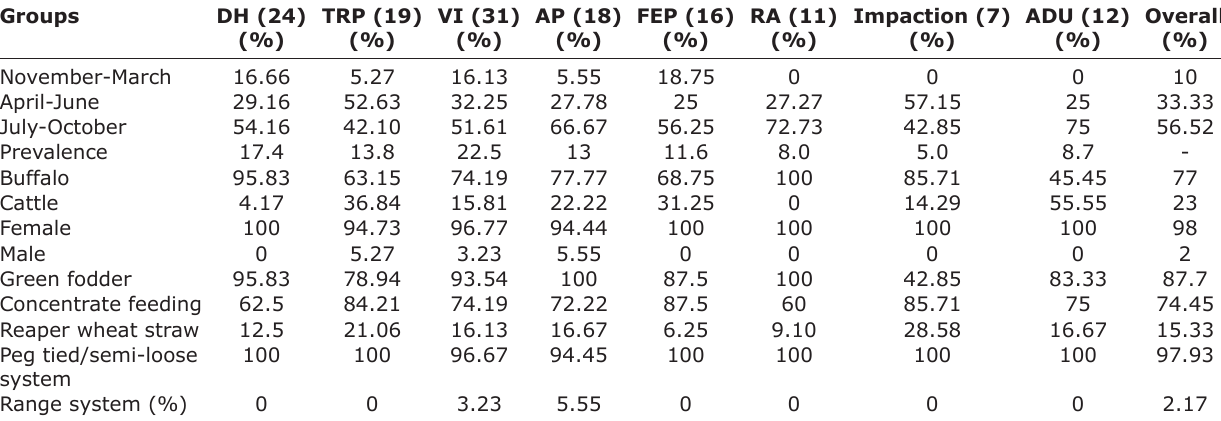
Table-1: Seasonal distribution, species differences and feeding practices in functional forestomach disorders.